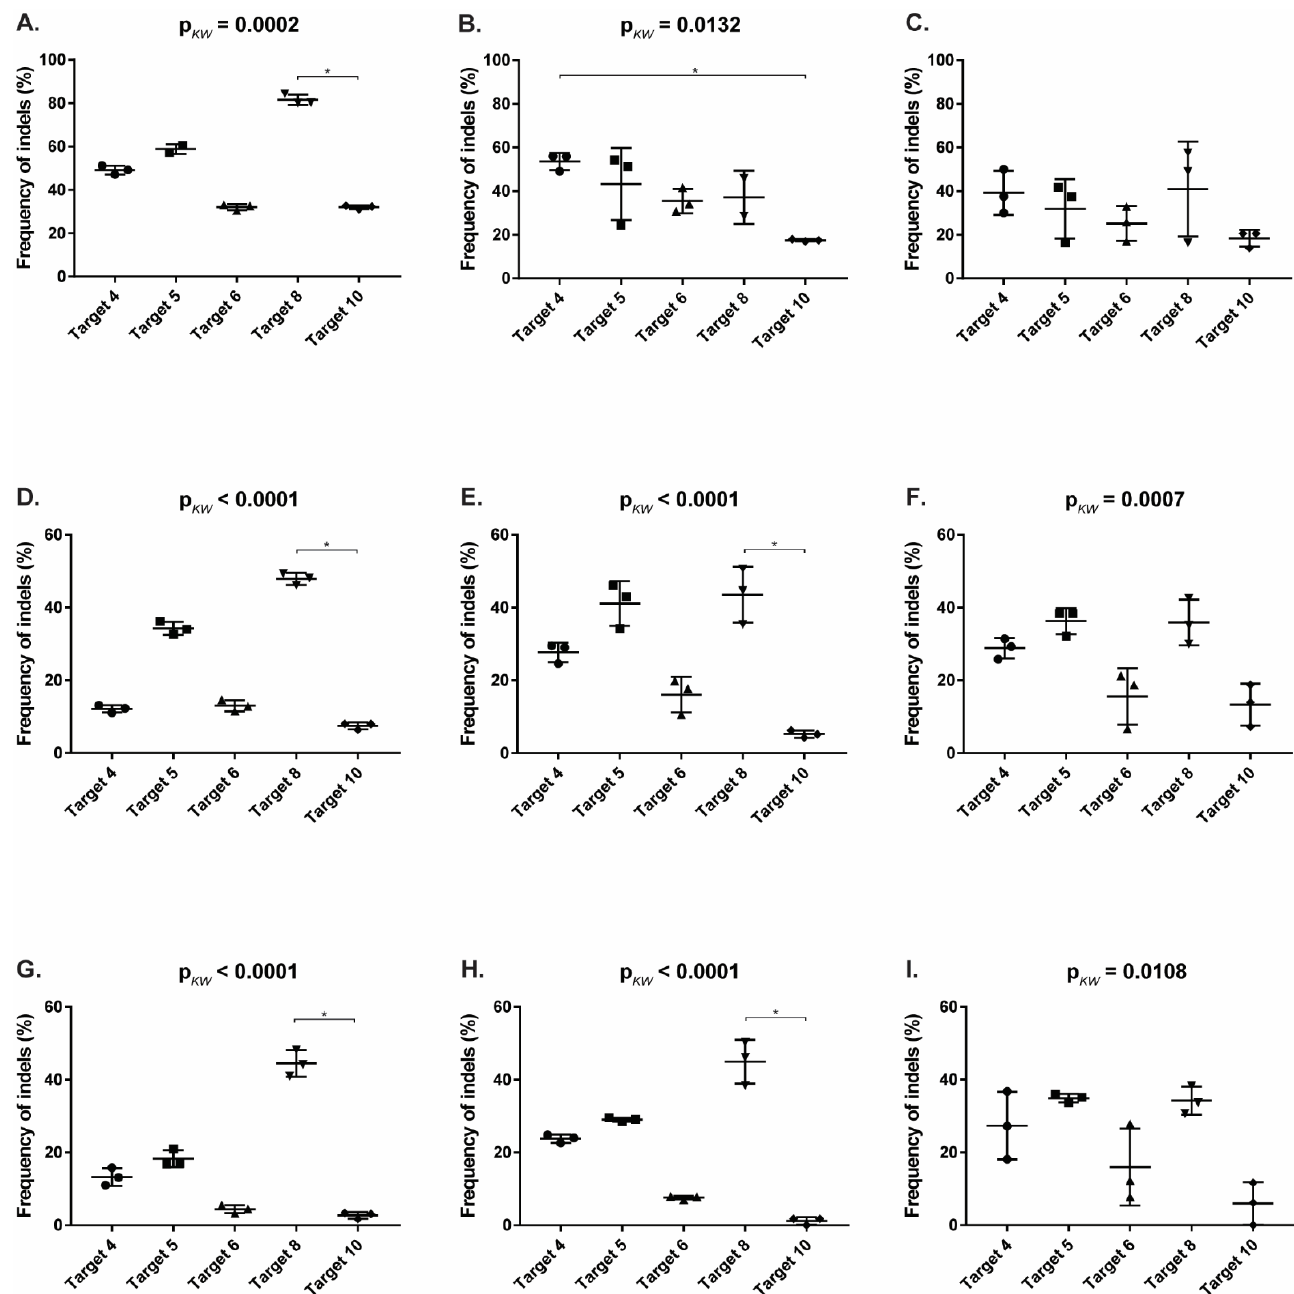
Figure A4. Comparison of CRISPR/ Sa Cas9 activity leading to indels after transduction. After CRISPR/ Sa Cas9 transduction using the AAV-DJ vectors vT4 (Target 4, vKHH1), vT5 (Target 5, vKHH3), vT6 (Target 6, vKHH4), vT8 (Target 8, vKHH2), and vT10 (Target 10, vKHH5), frequency of indels (%) were compared using TIDE ( A , D , G ) and the T7E1 assays. T7E1 efficiency was determined by parallel capillary electrophoresis using a fragment analyzer (FA, graphs ( B , E , H )) and band intensity comparison on an agarose gel ( C , F , I ). Transductions were performed on CRFK ( A – C ), FEA ( D – F ), and PG-4 cells ( G – I ). Frequency of indels (%) was tested for significant differences by Kruskal–Wallis, one-way ANOVA by ranks (p KW as indicated), and subsequently by Dunn’s post-test: * = p < 0.05. The data are shown as scatter dot plots. The horizontal line represents the mean with SD.